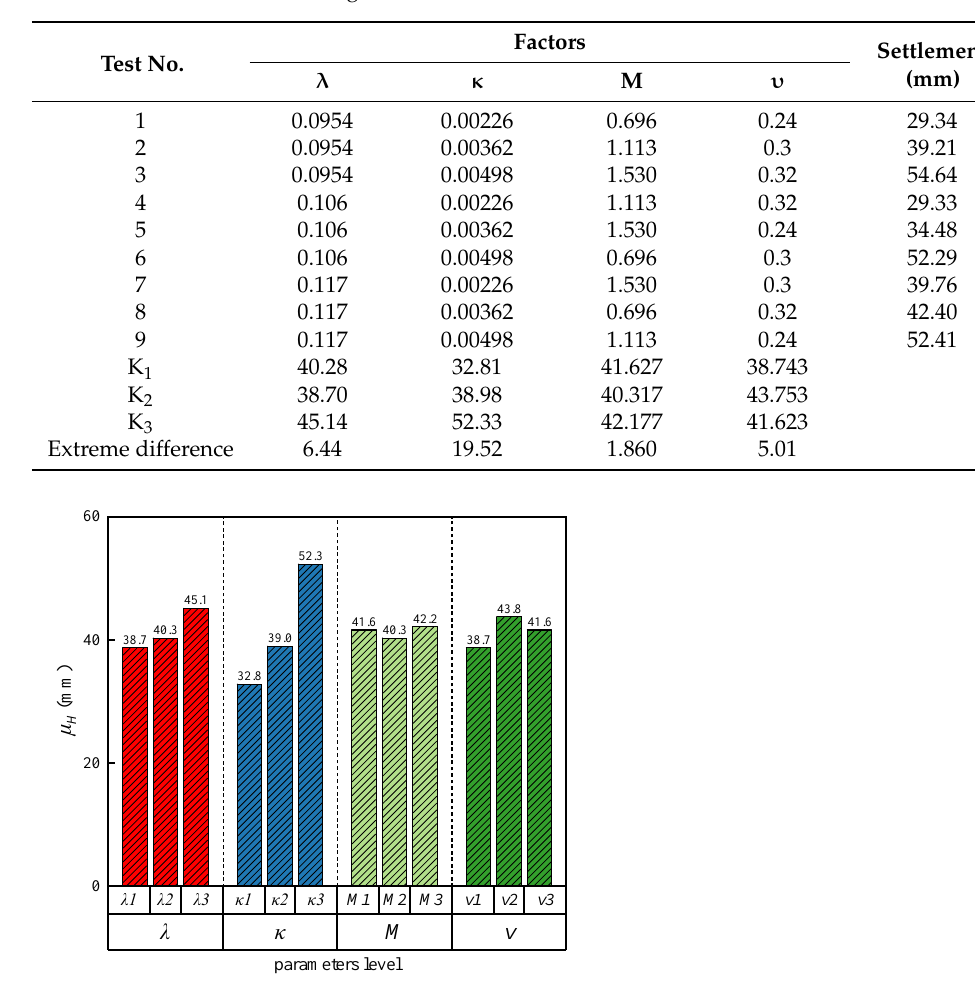
Table 5. The results of the orthogonal tests.